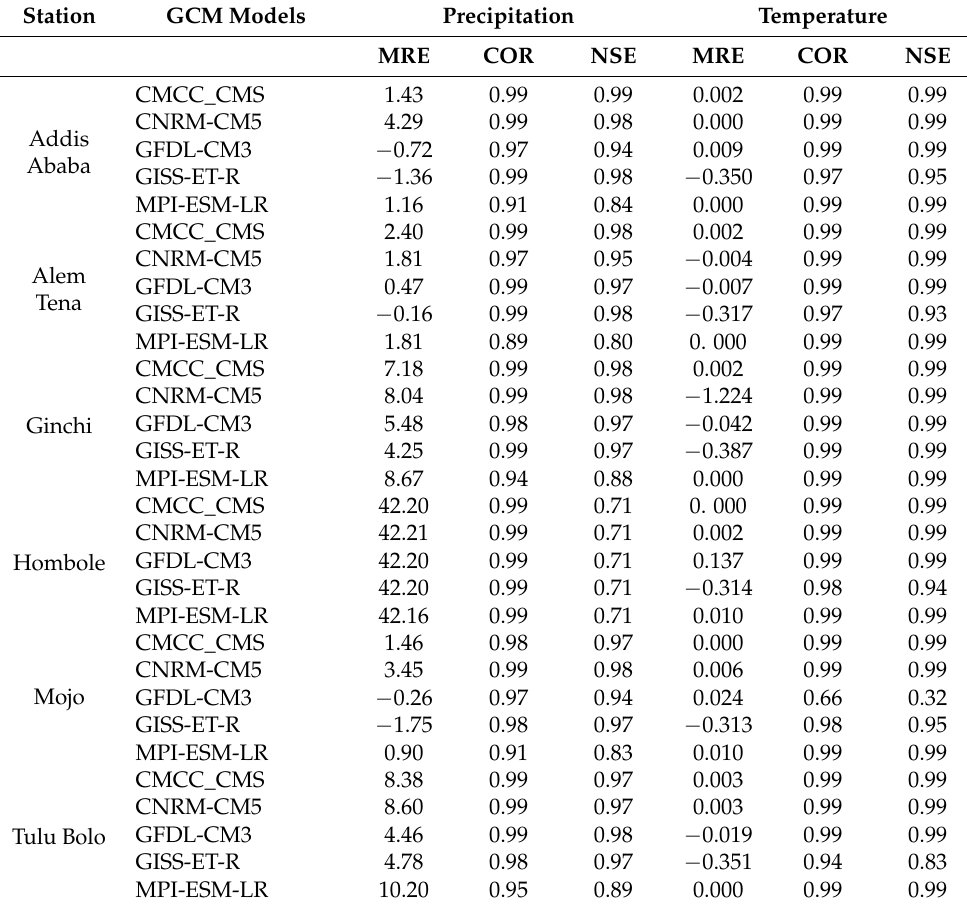
Table A1. Simulation performance of different